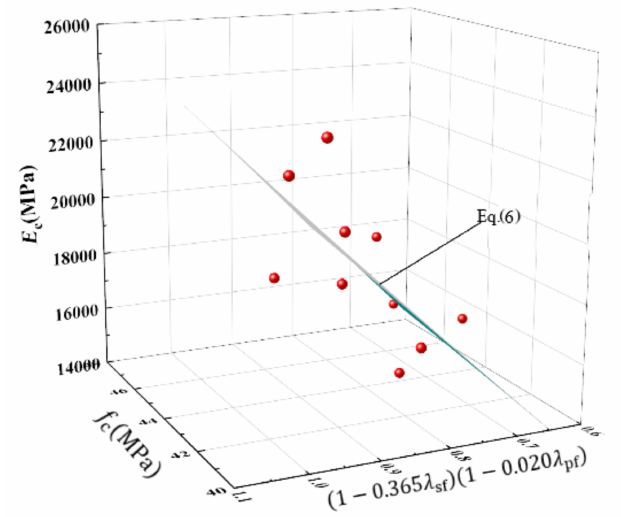
Figure 15. The function of fibre characteristic value, elastic modulus, and uniaxial compression strength.